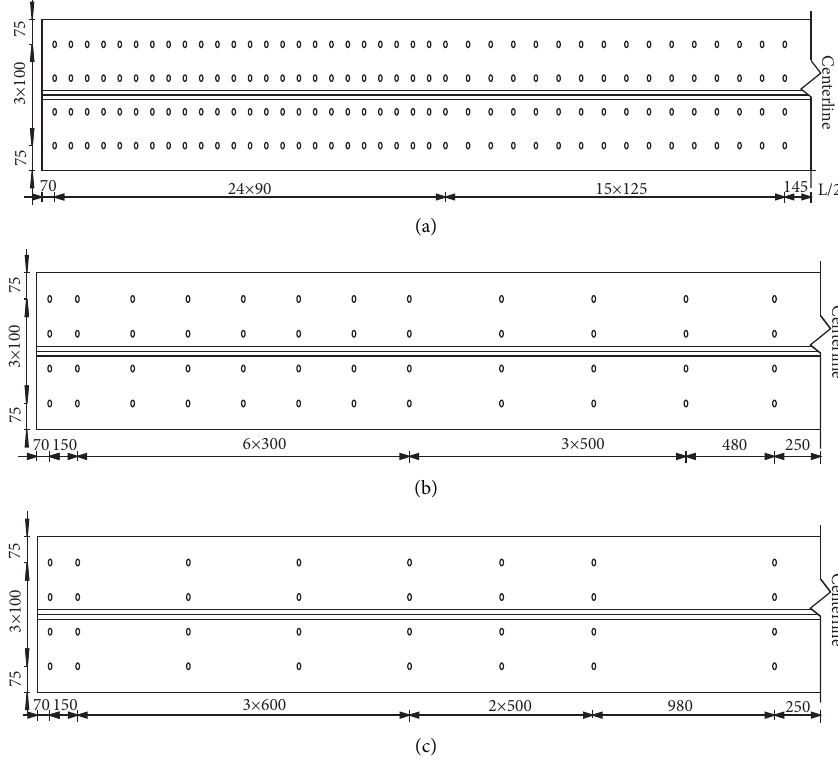
Figure 11: Different layouts of the shear studs. (a) Case1 (320). (b) Case 3 (96). (c) Case 4